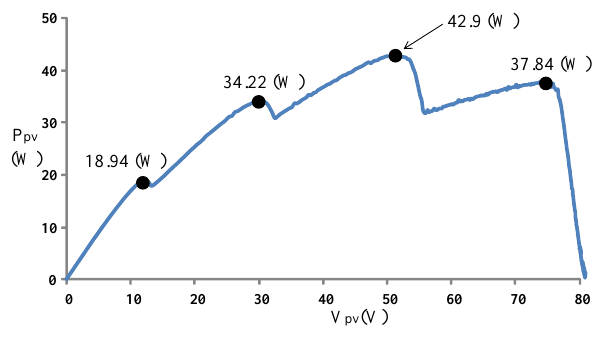
Figure 15. P–V characteristic curve of Case 3.